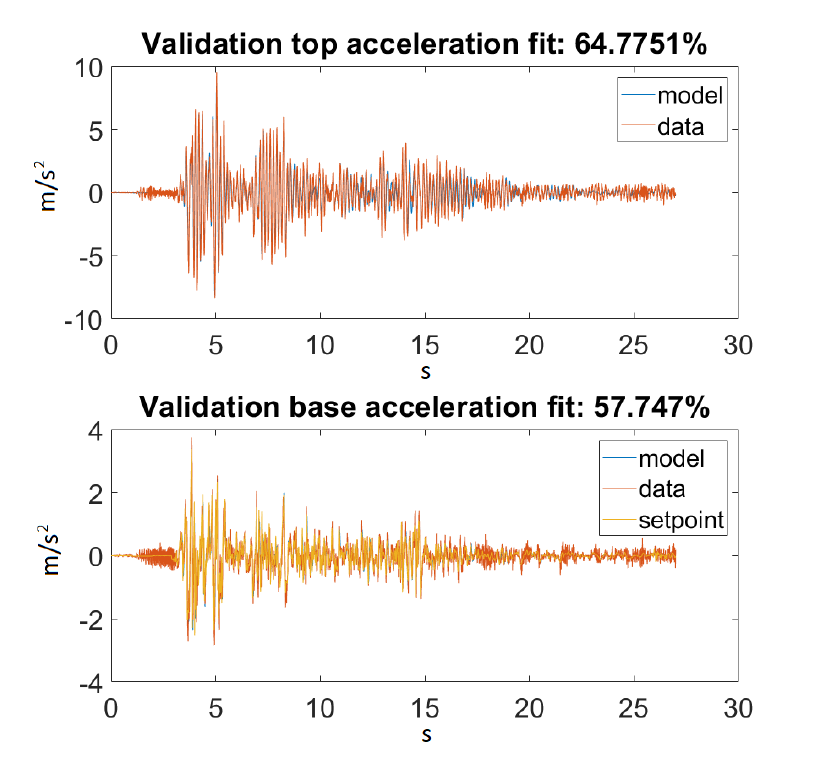
Figure 14. Best fit for Ground Motion